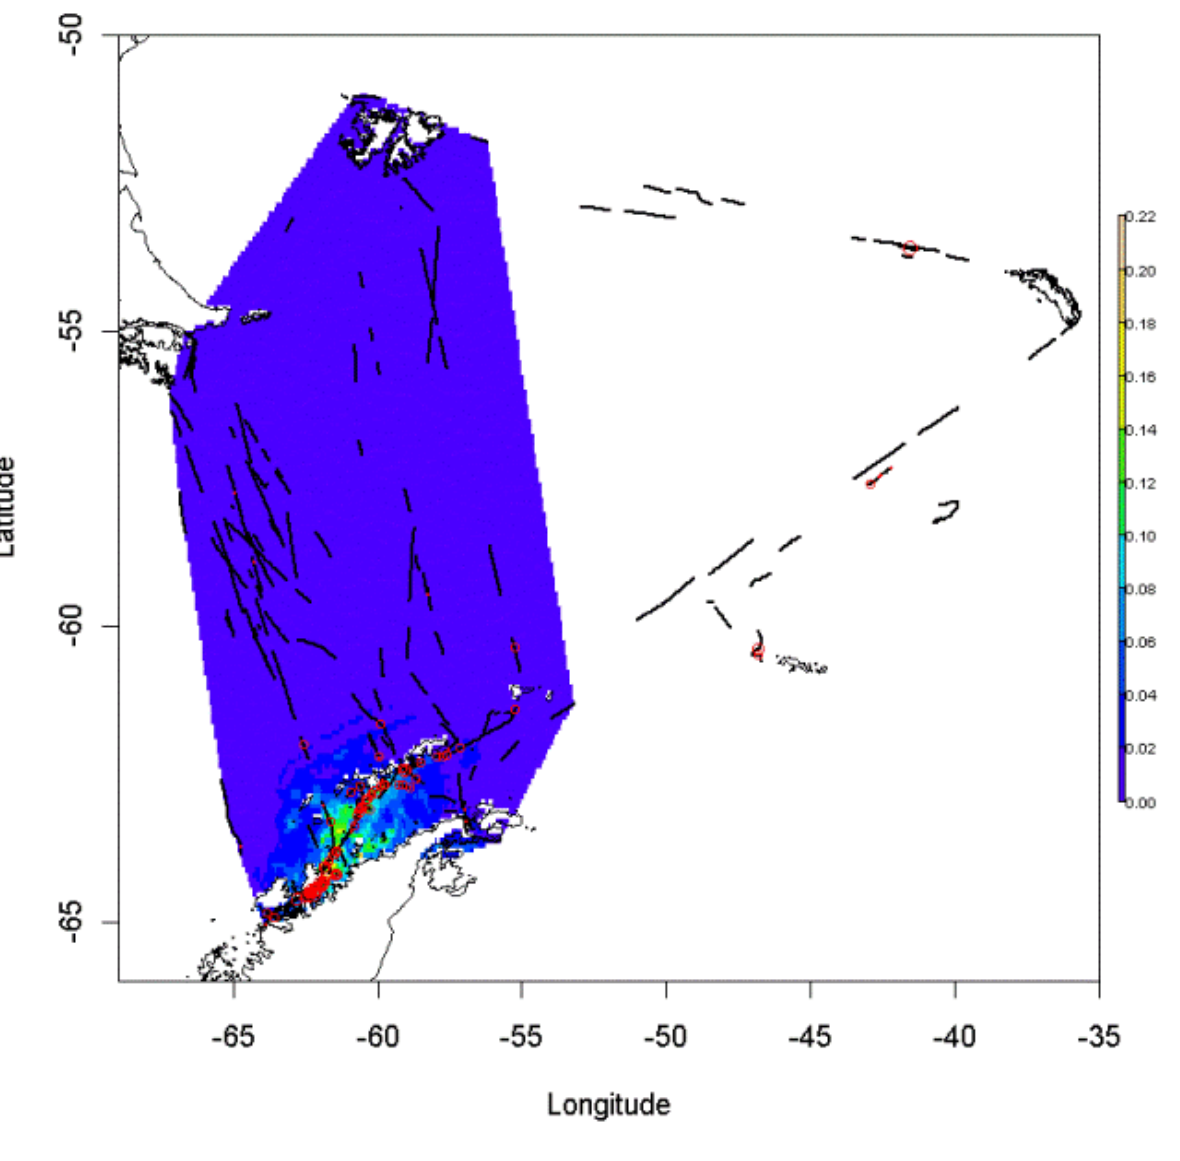
Fig. 2. Predicted density gradient of humpback whale schools in the best-covered region of the study area. The scale bar on the right is in units of schools per nm 2 . Tracklines are shown as solid black lines, and humpback sightings shown as red circles with radius proportional to school